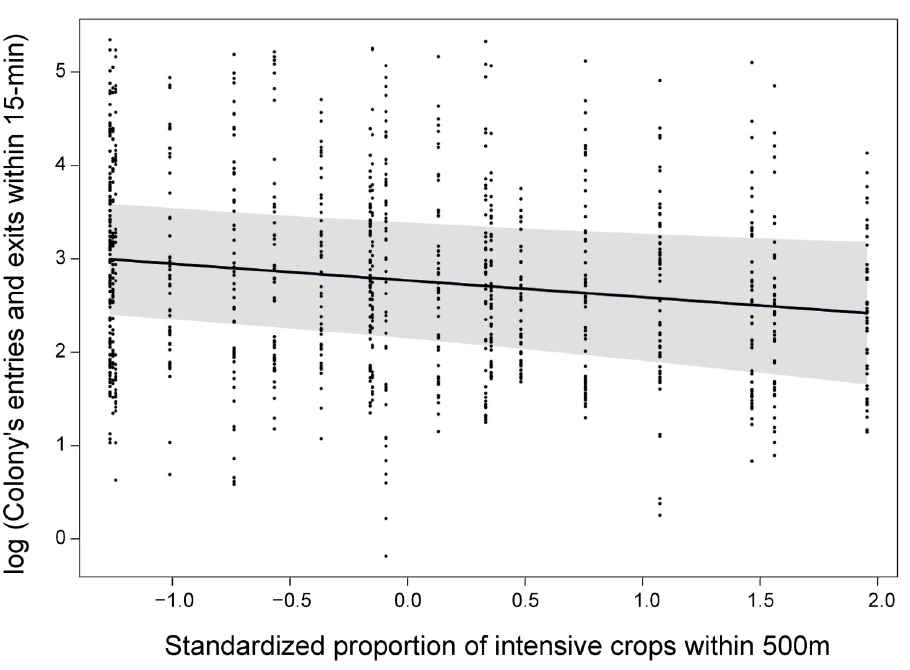
Fig 2. Influence of intensive crops (500-m radius) on the foraging activity (log(entries and exits in 15 min)) of Bombus impatiens workers. Data from the 20 clusters composed of 4 experimental colonies (quads) of Bombus impatiens monitored in 2016 in Southern Que´bec, Canada. Model-averaged predictions under average conditions are shown with 95% unconditional confidence intervals.